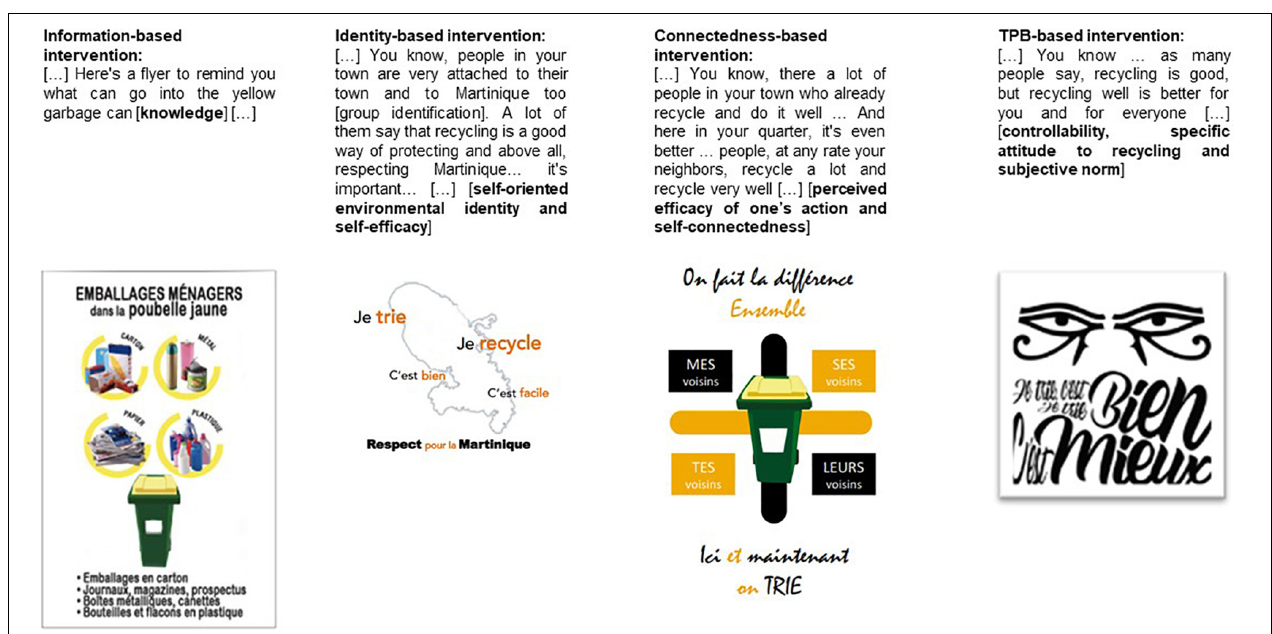
FIGURE 2 | Stickers illustrating the combination of the determinants of recycling. TABLE 5 | Descriptive analysis of the sample among the four conditions of the 119 households. Information-based